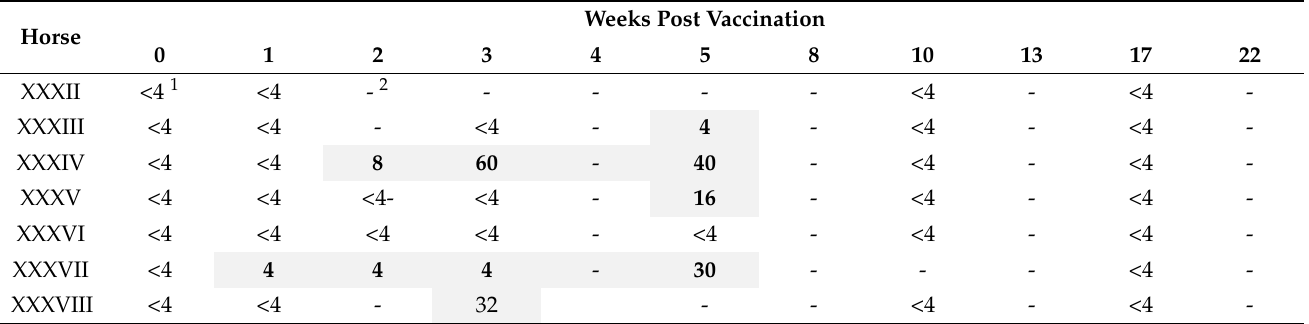
Table 4. Neutralizing antibody titers after first vaccination with BoDV-1 live vaccine “Dessau” in